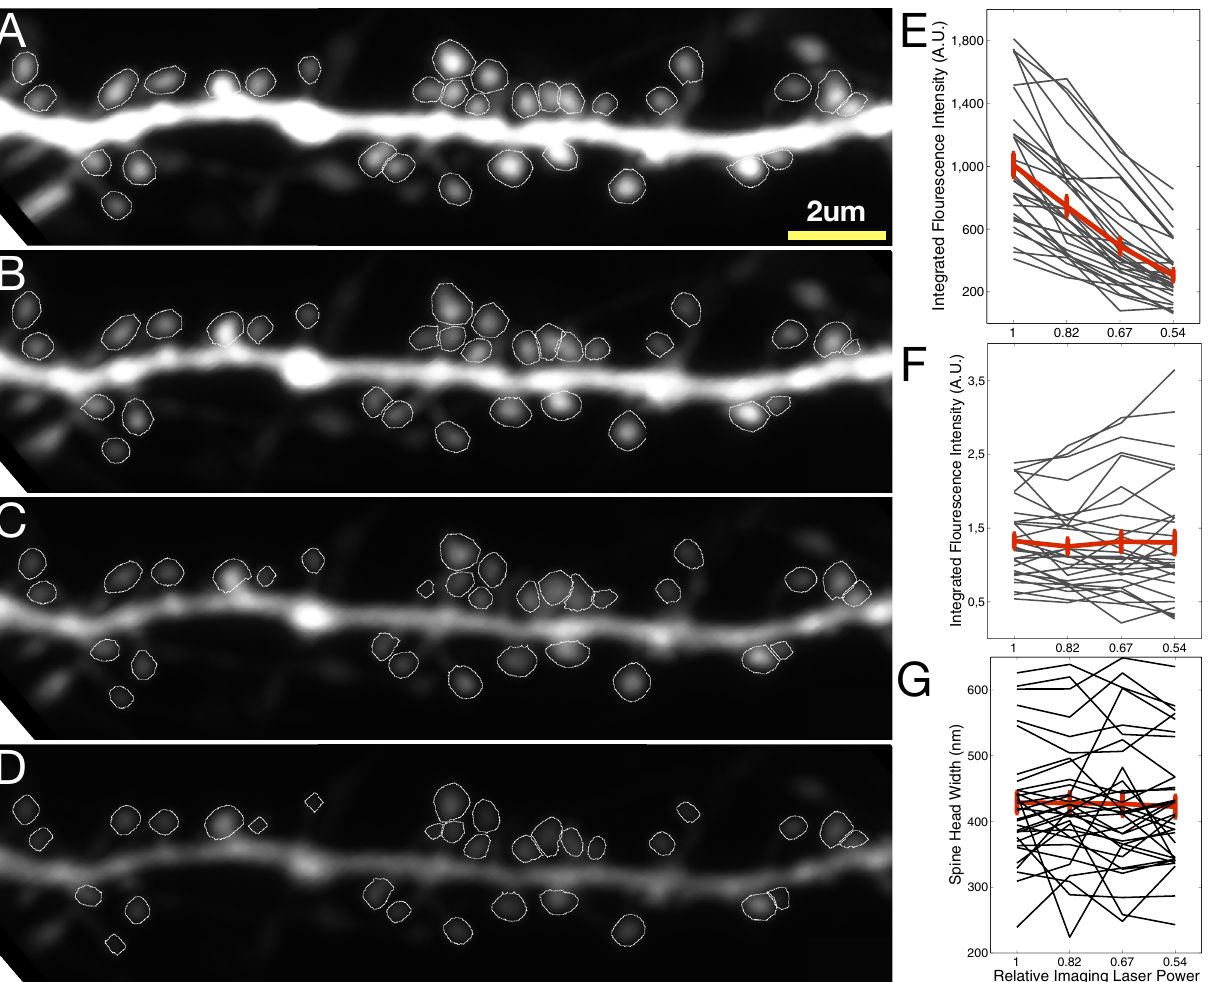
Figure 5. Performance of segmentation and volume estimation are not intensity dependent. ( A–D ) Maximum intensity projection of two-photon microscopy images collected using different imaging laser powers as the tissue was perfused with ACSF containing TTX to prevent short-term plastic changes at the dendritic branch. ( E ) Individual (gray) and average (red) intensity-based volume estimation of segmented spines. ( F ) Normalised integrated fluorescence intensity after normalisation with median intensity value at the dendrite. ( G ) FWHM estimated spine head